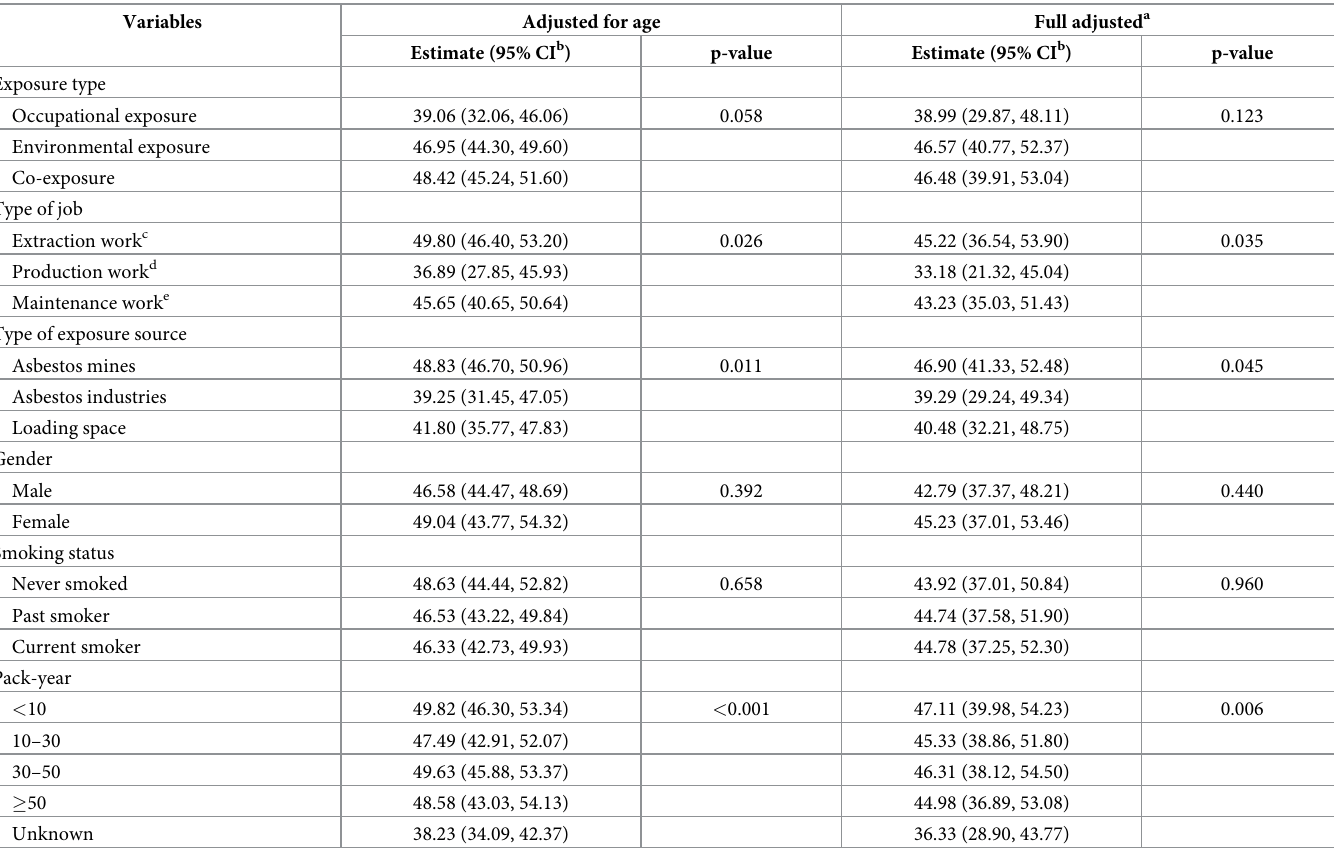
Table 6. Adjusted mean latency periods according to the characteristics of the